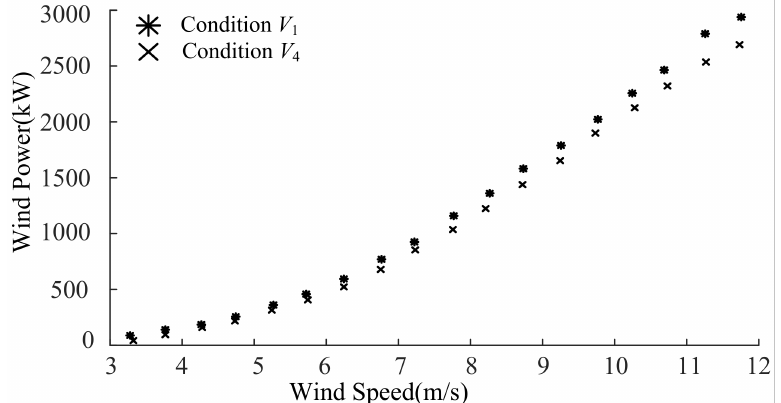
Figure 6. Power curves in different